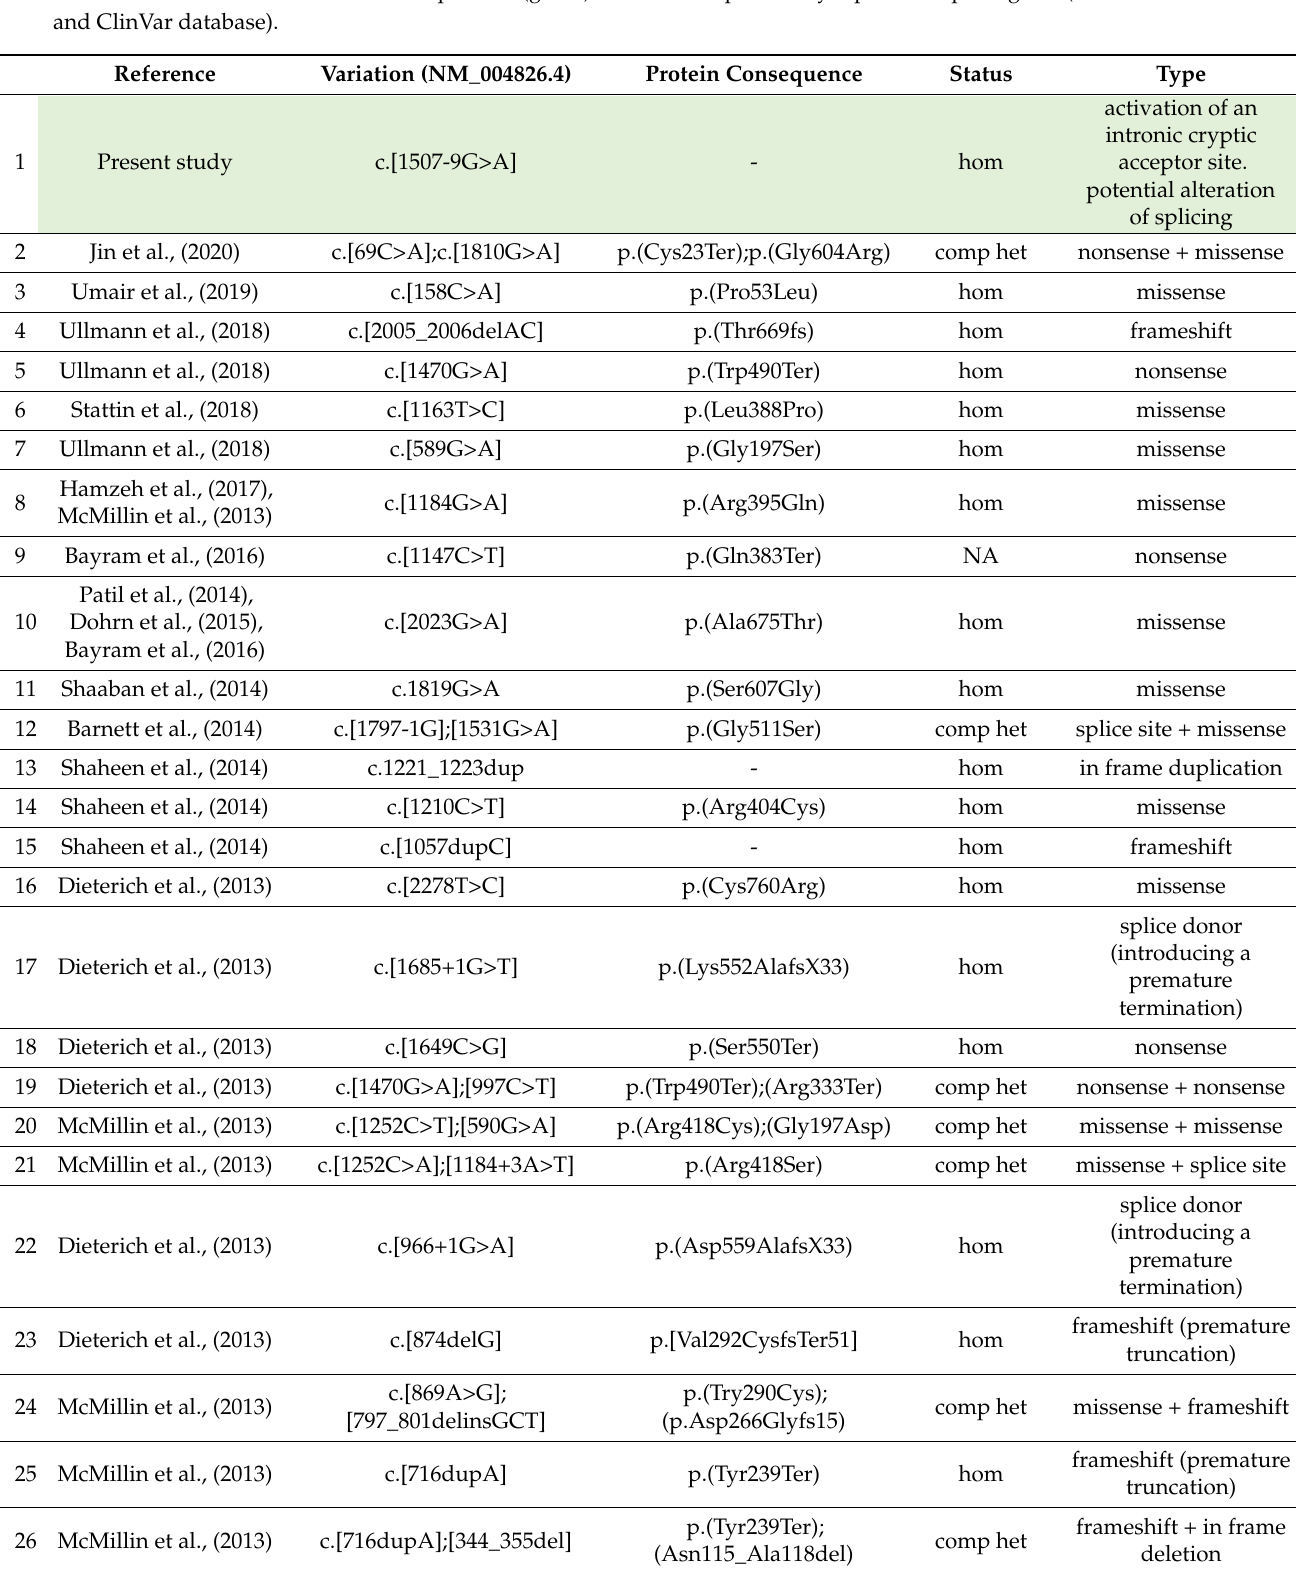
Table 2. ECEL1 variant detected in our patients (green) and variants previously reported as pathogenic (scientific literature and ClinVar